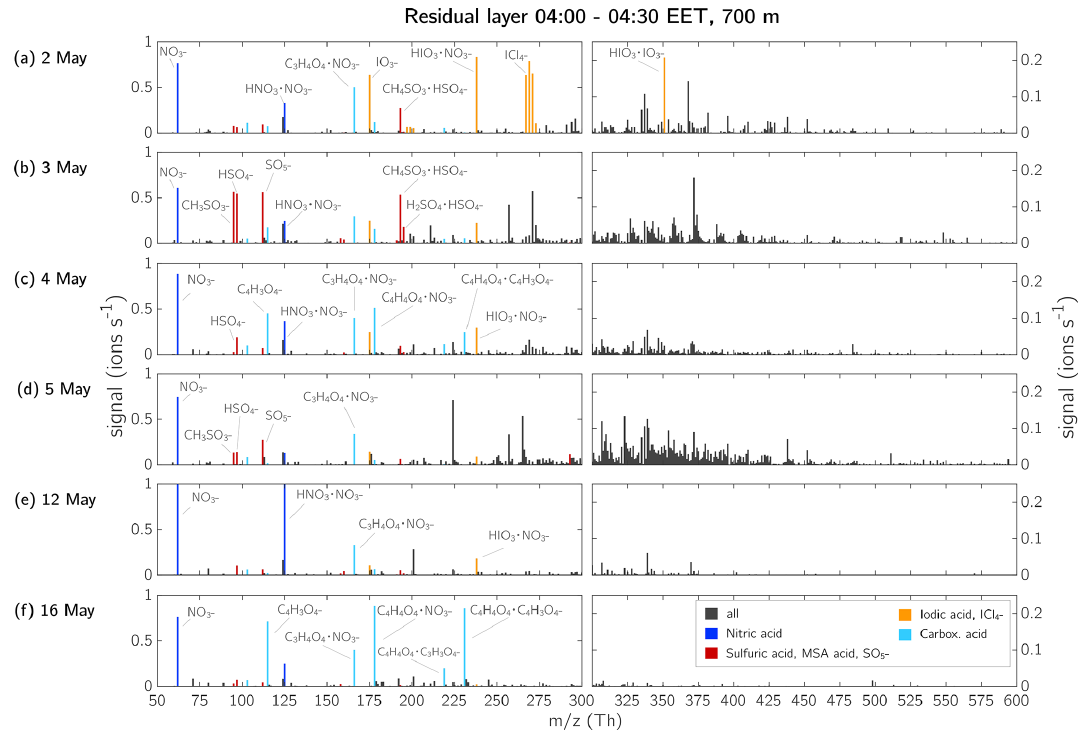
Figure 13. Ion spectra inside the RL at 700m during early morning between 04:00–04:30EET. Each row is showing one measurement flight: (a) 2 May, (b) 3 May, (c) 4 May, (d) 5 May, (e) 12 May, and (f) 16 May 2017. The mass axis is split at 300Th such that the limits of the vertical axis could be adapted to make the ions > 300Th more visible. Please note that unlike in Figs. 6, 7, and 10, the signal > 300Th is not coloured green. The majority of the compounds is HOM dominated, but also other ions are abundant and to avoid possible false colour coding in this higher-resolution figure, the colour is kept neutral. The elemental composition of ions with a high signal that could be identified are noted in the figure. The 700m height level was within the RL on each measurement day. The boundary layer height and development can be determined from Fig. S16 in the Supplement. The nitric acid signal exceeds the limits of the vertical axis on 12 May 2017 in panel (e) : [NO − ] = 1.93 ionss − 1 , [HNO 3 · NO − ] = 1.18 ionss − 1 3 3